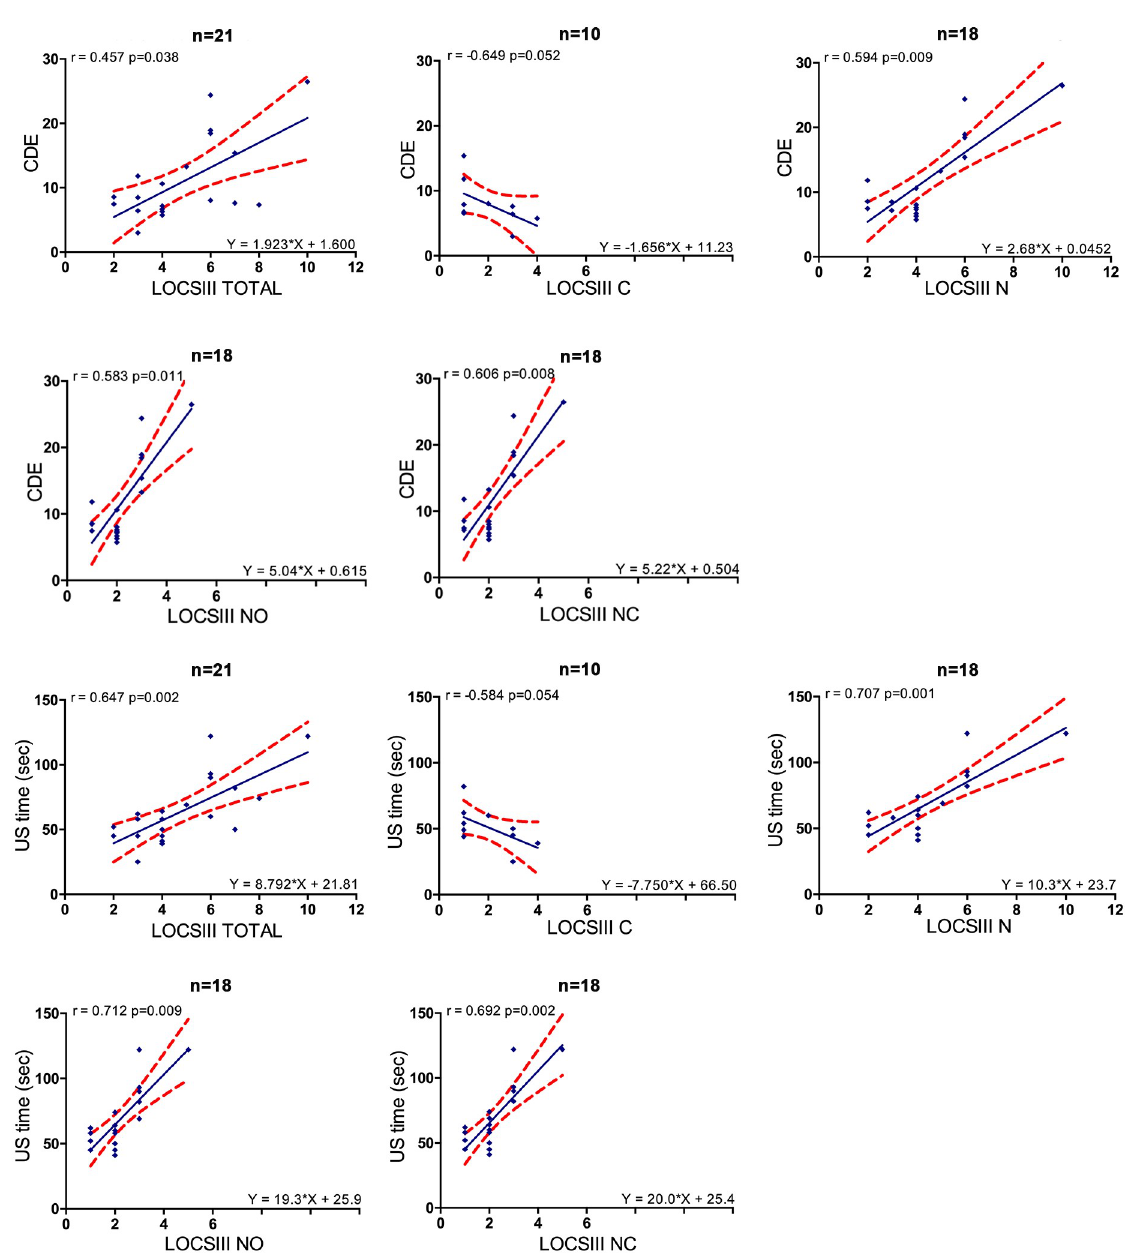
Fig 3. Linear regressions between LOCS III and surgical parameters. Red dots show the 95% CI of the slope and intercept. CDE = cumulative dissipated energy, US = ultrasound, LOCS III = lens opacity classification system III, N = nuclear component = (NO +NC), NO = nuclear opalescence, NC = nuclear color, C = cortical opacities.